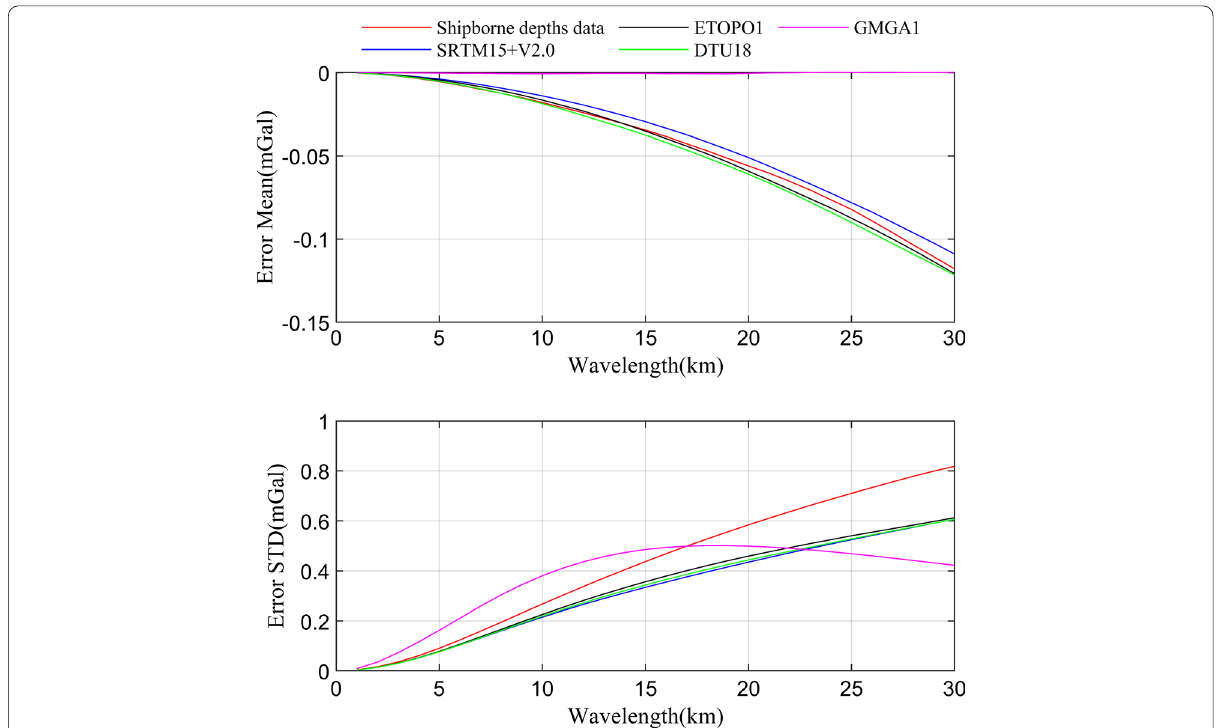
Fig. 8 Accuracy of short wavelength gravity anomaly with variations of